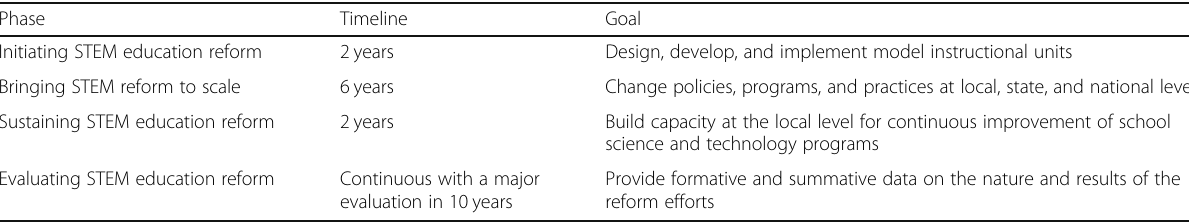
Table 1 A decade of action: phases and goals